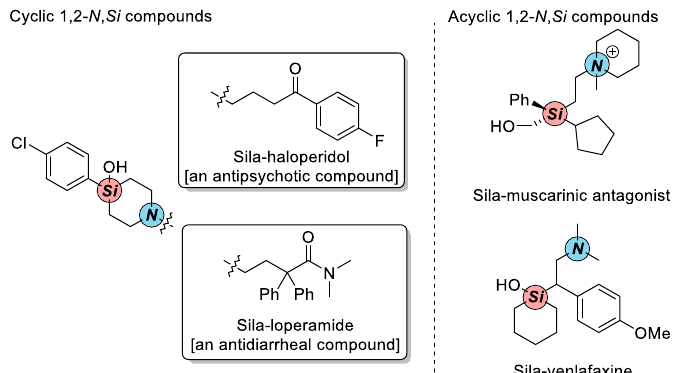
Fig. 1 Representative 1,2- N,Si compounds in Pharmaceuticals. Cyclic and acyclic 1,2- N,Si compounds in